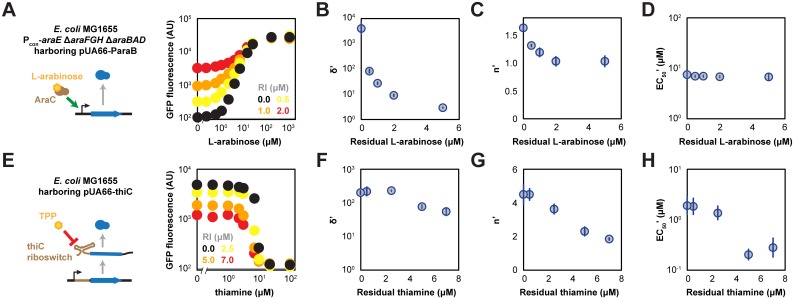
Impact of residual inducer on titratable systems in E. coli.(A) Response curves for E. coli MG1655 Pcon-araE ΔaraE ΔaraBAD cells harboring pUA66-paraB. The GFP reporter is activated in the presence of L-arabinose. The concentration of residual L-arabinose (RI) is indicated. The gray bar represents the measured fluorescence of the same E. coli cells harboring pUA66. Impact of residual L-arabinose on (B) the apparent dynamic range (δ’), (C) the apparent Hill coefficient (n’), and (D) the apparent half-maximal inducer concentration (EC50’) for Pcon-araE ΔaraE ΔaraBAD cells. (E) Response curves for E. coli MG1655 cells harboring pUA66-thiC. The GFP reporter is repressed in the presence of thiamine. The concentration of residual thiamine is indicated. The gray bar represents the measured fluorescence of the same E. coli cells harboring pUA66. Impact of residual thiamine on (F) the apparent dynamic range (δ’), (G) the apparent Hill coefficient (n’), and (H) the apparent half-maximal inducer concentration (EC50’) for MG1655 cells. Values represent the mean and S.E.M. of independent experiments with at least three separate colonies.